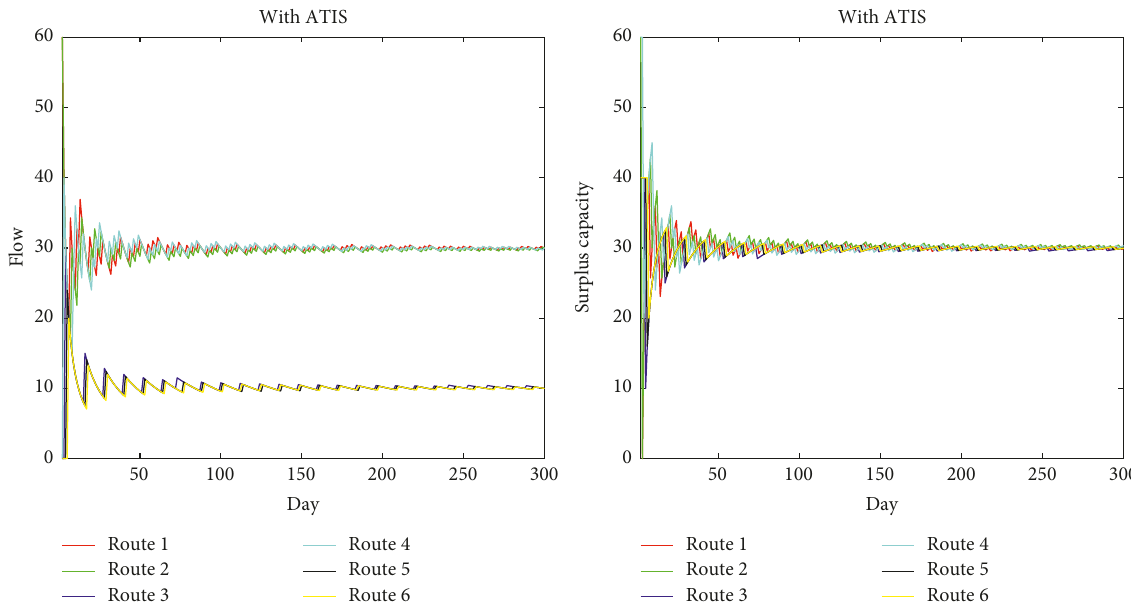
Figure 6: Evolutionary trajectories of route flows (a) and route surplus capacity (b) for travellers in the second group.